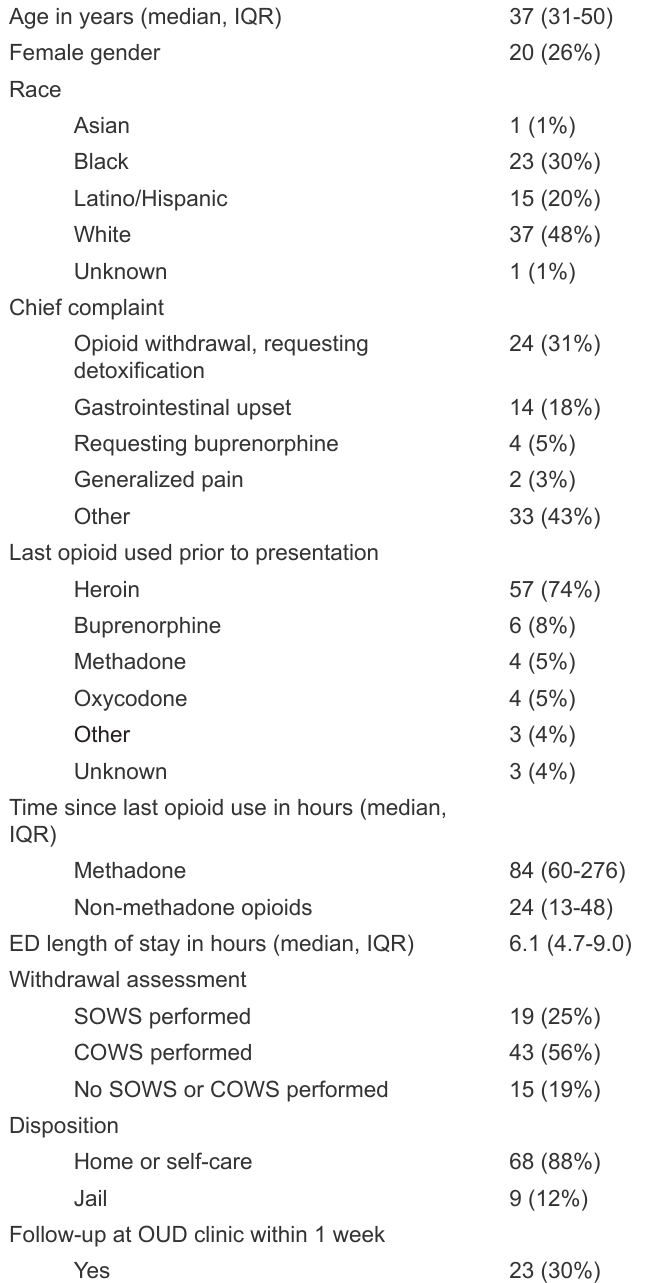
Table 1 . Baseline characteristics of emergency department patients who received buprenorphine for opioid withdrawal (N =